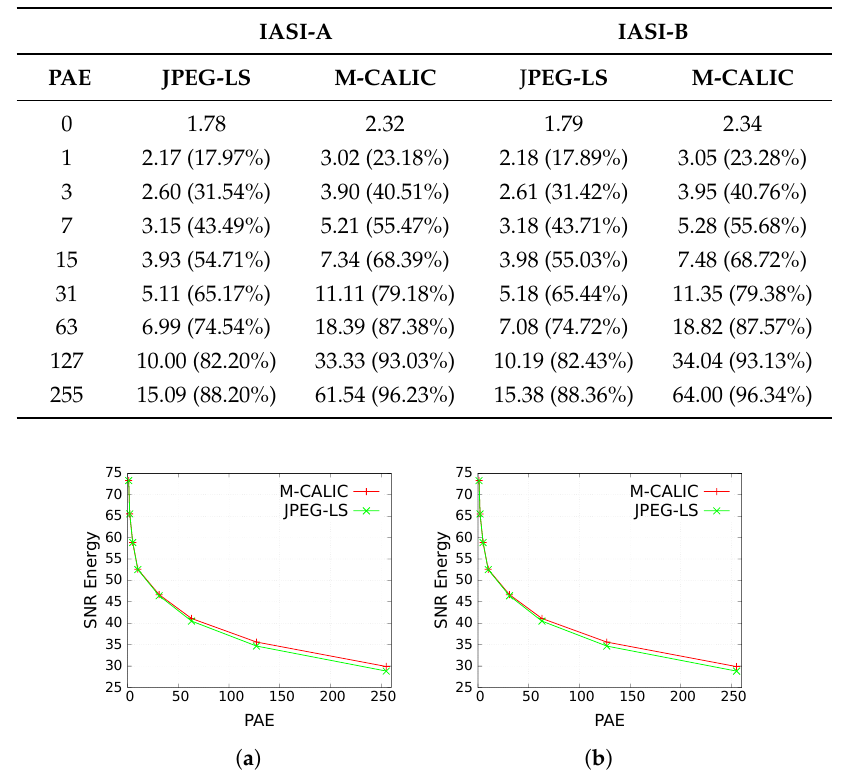
Figure 11. Rate-distortion performance of near-lossless compression of IASI L1C products. Results report SNR Energy (in dB, higher is better) vs. PAE. ( a ) IASI-A; ( b )